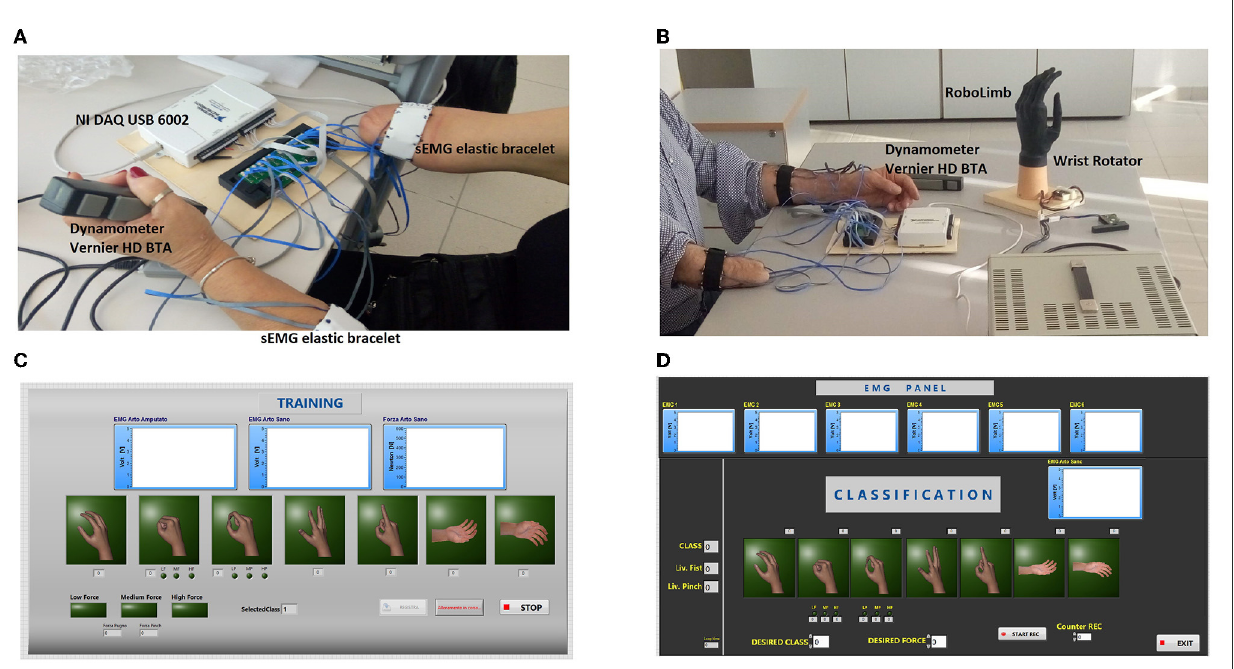
FIGURE1 (A) The experimental setup for steps 1 and 2. Six sEMG sensors for each elastic bracelet, the NI DAQ USB 6002, and two hand dynamometers. (B) The experimental setup for step 3. The same elements of (A) with the RoboLimb and wrist module. (C) The software interface for step 2. (D) The software interface for step